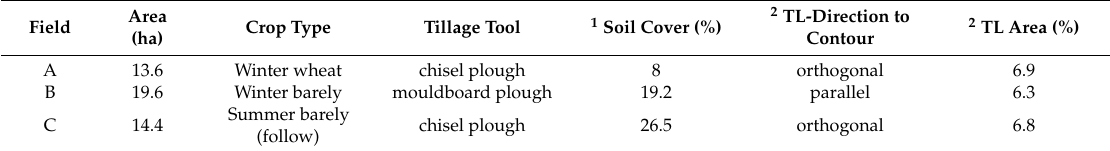
Table 1. Selected fields and field characteristics for soil erosion modelling (Date: 13 October 2017).